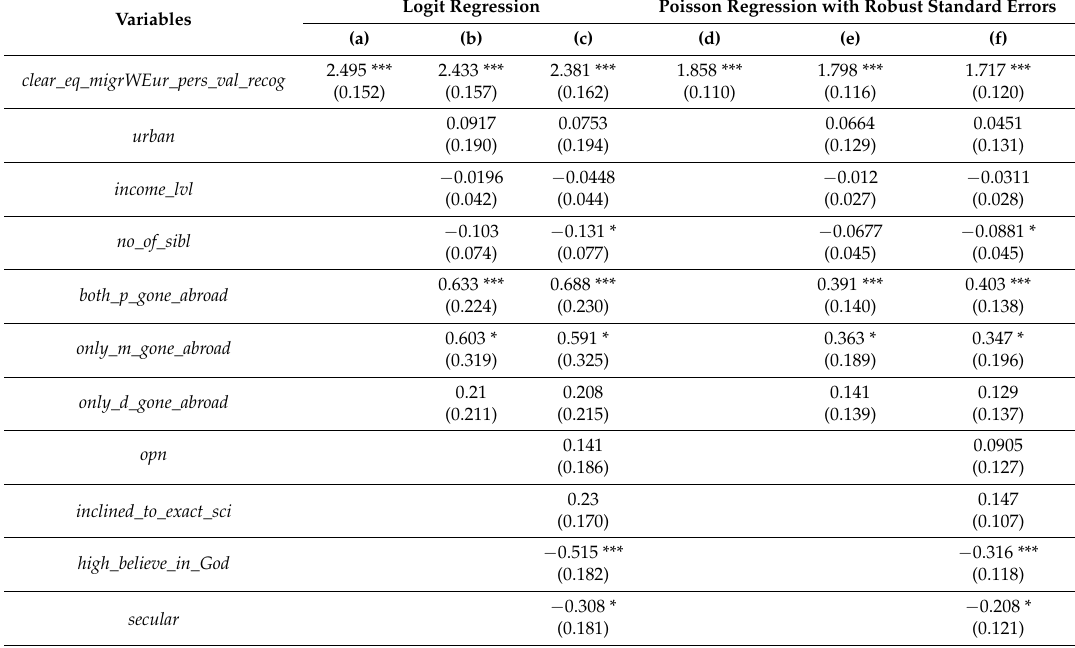
Table 3. Raw coefficients (Logit vs. Poisson) of the model based on responses from FSEGA, UBB